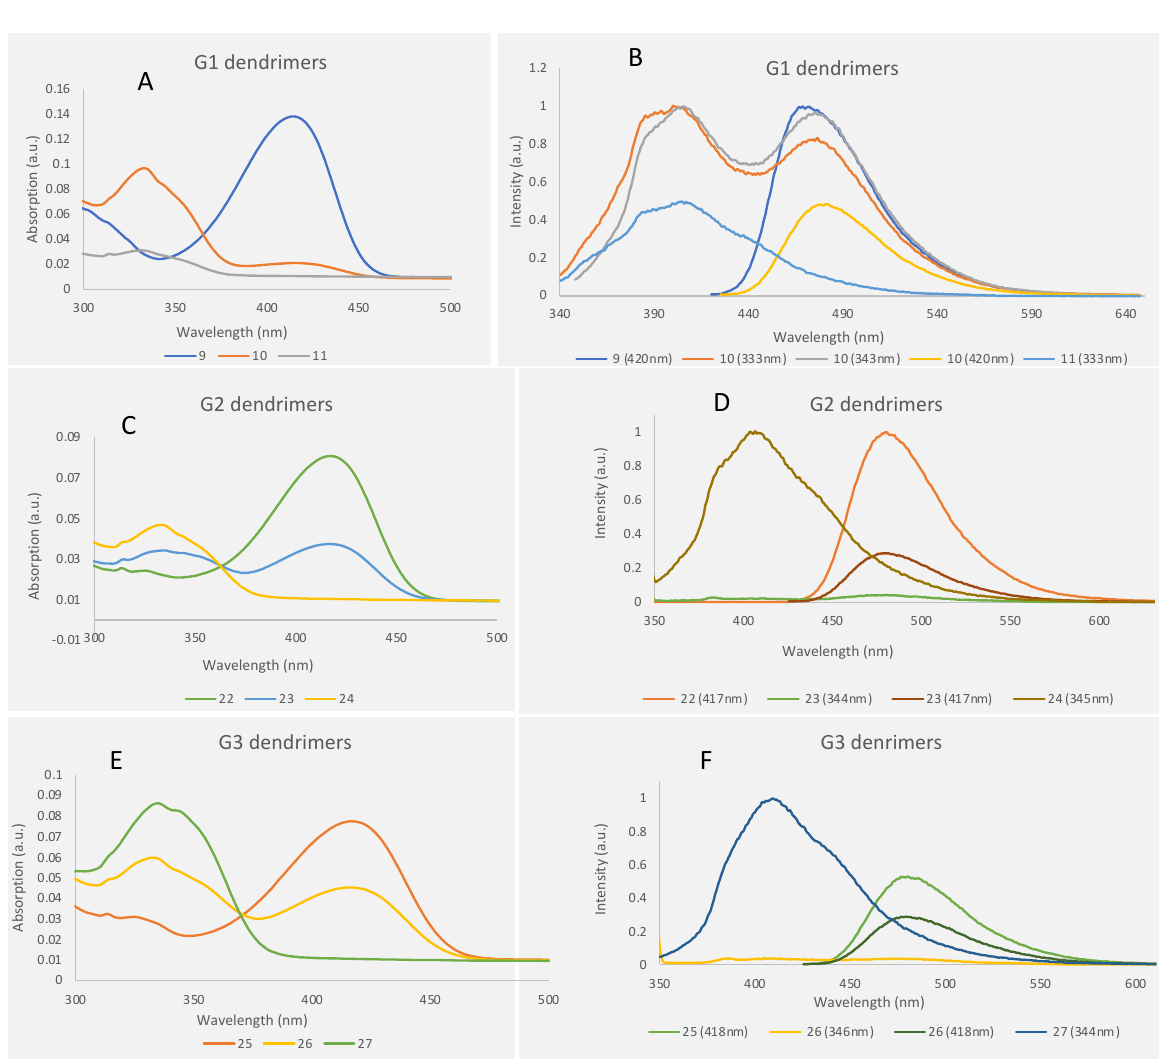
the corresponding blue–fluorescent homodendrimer. For example, blue–fluorescent G3 Janus dendrimer 26 was slightly absorbed at a longer wavelength (495 nm) compared to its blue–fluorescent homodendrimer analog 25 (489